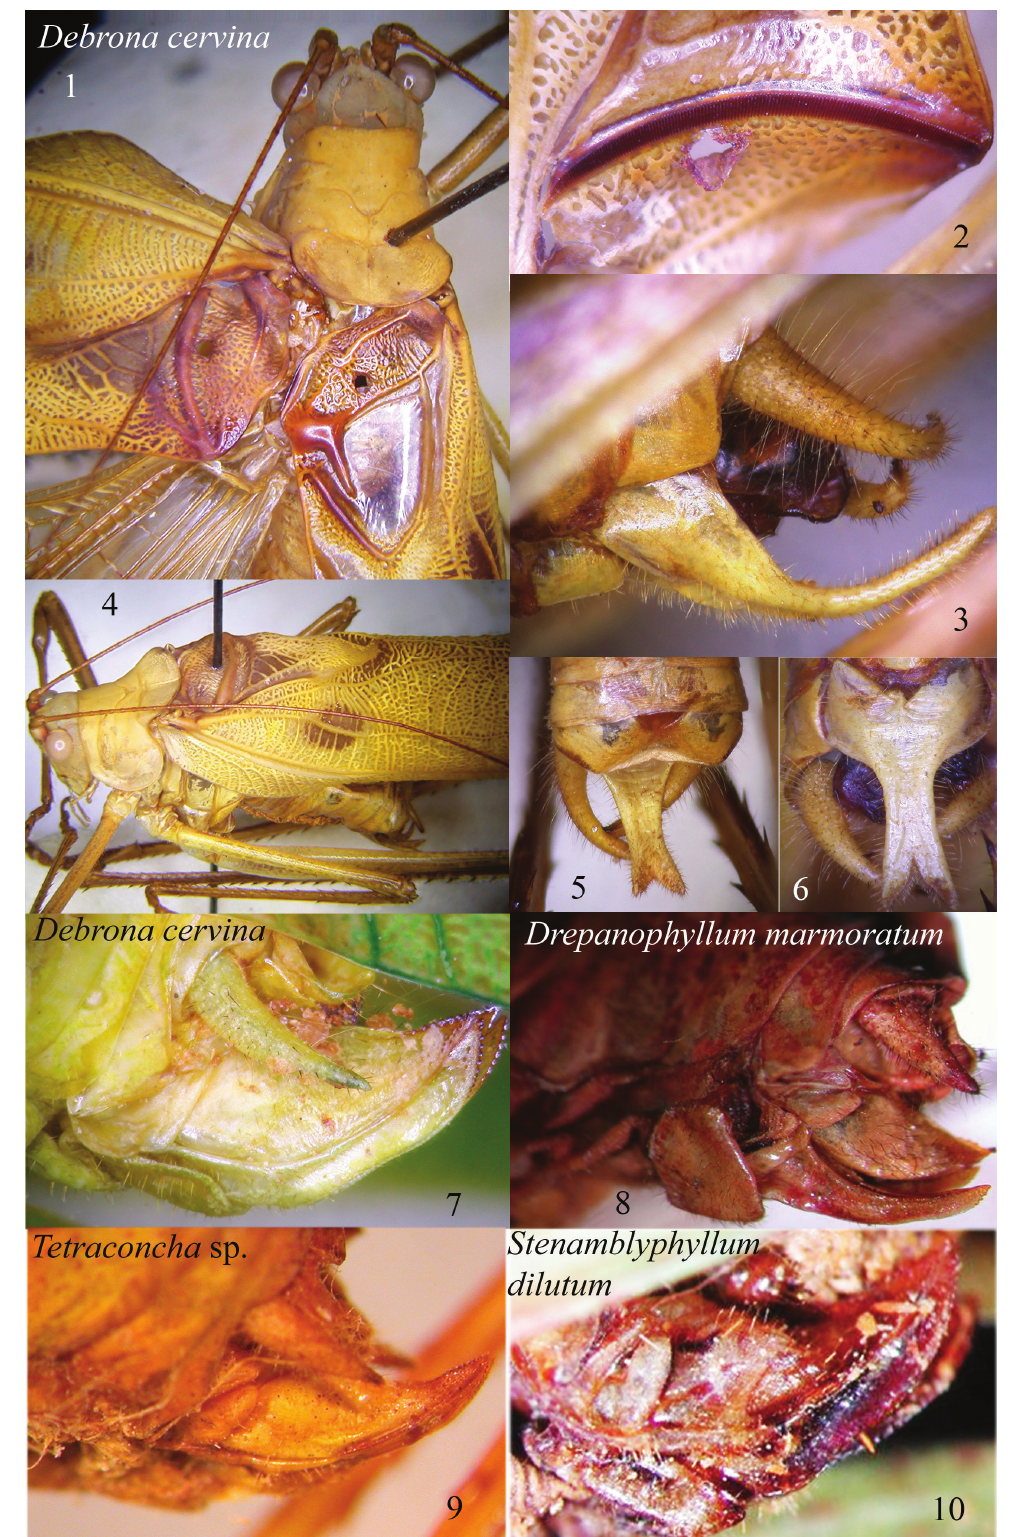
Figs 1–10. Debrona cervina male (Kenya, Arabuko Sokoke Forest): 1. Stridulatory area; 2. Stridulatory file below the left tegmen; 3. Cerci and subgenital plate in lateral view; 4. Habitus in dorsal view; 5. Subgenital plate in dorsal view; 6. Subgenital plate in ventral view. Debrona cervina female (same locality): 7. Ovipositor in lateral view. Drepanophyllum marmoratum female (Central African Republic, N’Doki): 8. Ovipositor in lateral view. Tetraconcha sp. (probably smaragdina ) female (Cameroon, Mukonje Farm): 9. Ovipositor in lat- eral view. Stenamblyphyllum dilutum lectotype female (Cameroon, Victoria): 10. Ovipositor in lateral